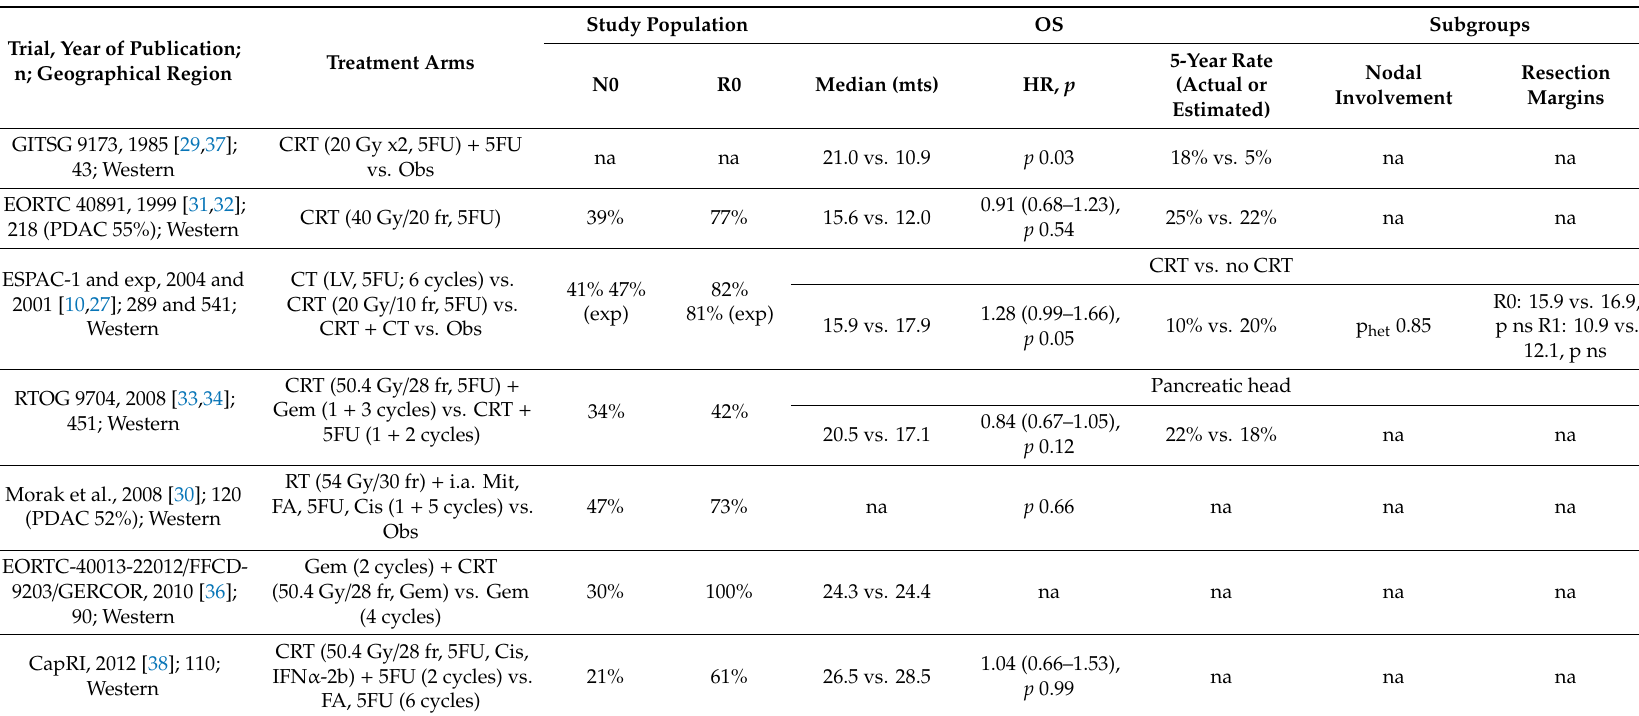
Table 2. OS outcomes of the published randomized, controlled trials of adjuvant CRT in